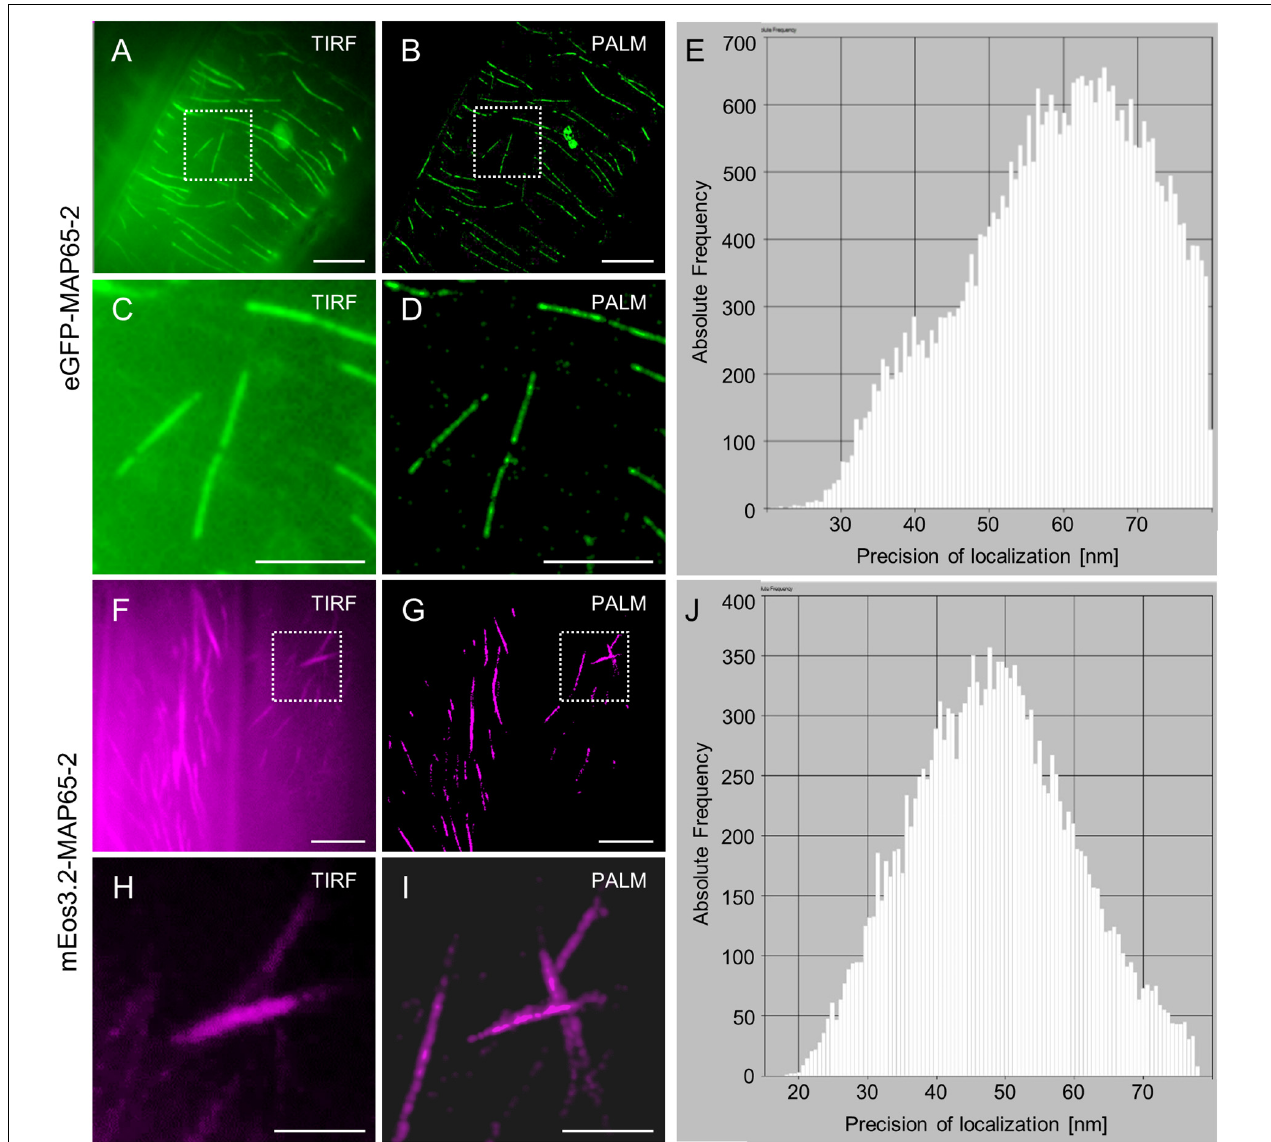
FIGURE 12 | Comparison of single molecule localization microscopy (SMLM) between eGFP-MAP65-2 stochastic optical fluctuations and mEos3.2-MAP65-2 photoconversion. (A,B) Comparative overviews of a hypocotyl cell expressing eGFP-MAP65-2 visualized after TIRF illumination (A) or following PALM reconstruction (B) . (C,D) Detailed comparisons of a magnified view of the boxed area in (A,B) under TIRF illumination (C) or PALM reconstruction (D) . (E) Histogram of precision of localization plotted against photon frequency. (F,G) Comparative overviews of a hypocotyl cell expressing mEos3.2-MAP65-2 by means of TIRF (F) or after PALM reconstruction (G) . (H,I) Detailed view of the boxed areas in (F,G) after TIRF acquisition (H) or PALM reconstruction (I) . (J) Histogram of precision of localization plotted against photon frequency. Scale bars = 10 µ m (A,B) ; 5 µ m (C,D,F,G) ; 2 µ m (H,I)